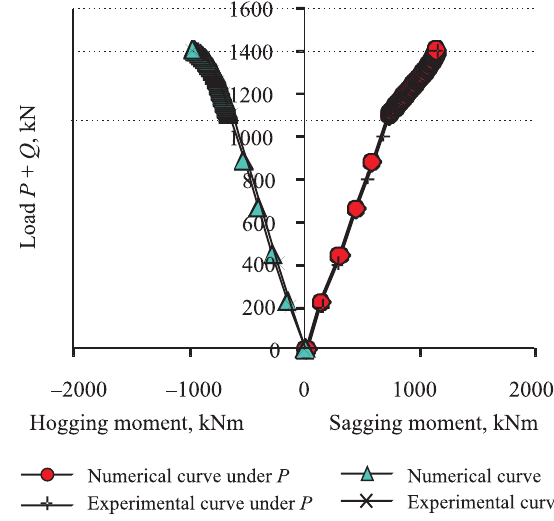
Fig. 7. Comparison of bending